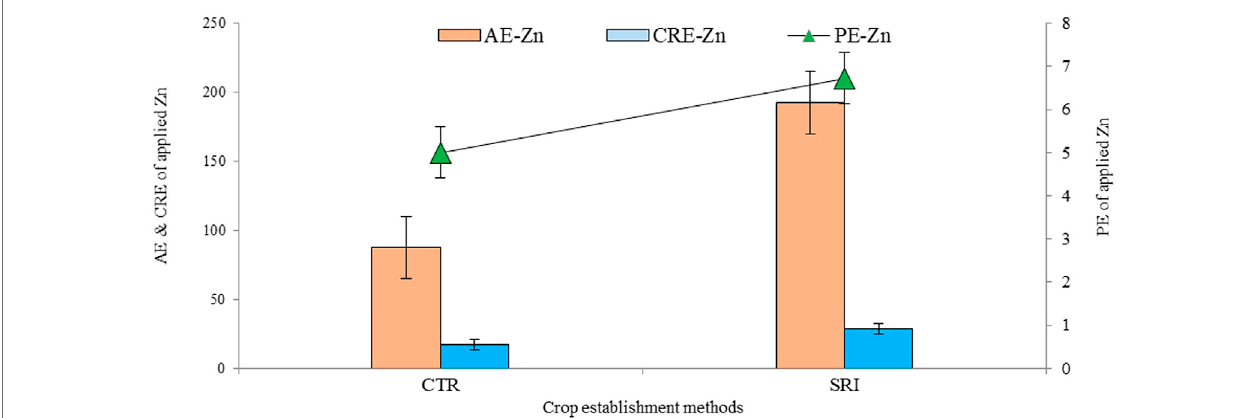
FIGURE 8 | In fl uence of Zn fertilization in rice on agronomic ef fi ciency of applied Zn (AE-Zn) (kg grain kg − 1 Zn applied), crop recovery ef fi ciency of applied Zn (CRE- Zn) (kg Zn accumulated kg − 1 Zn applied), and physiological ef fi ciency of applied Zn (PE-Zn) (kg grain kg − 1 Zn-uptake) under CTR and SRI (4 years av.). The vertical bars indicate the standard deviation.